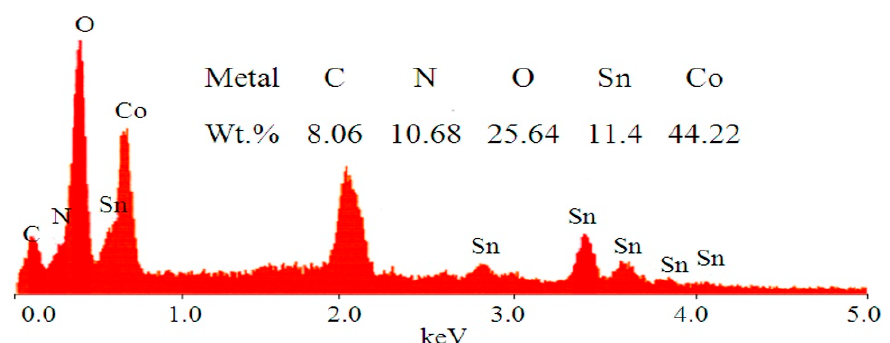
Figure 3. Energy dispersive X-ray spectrum of CSLDH-1.